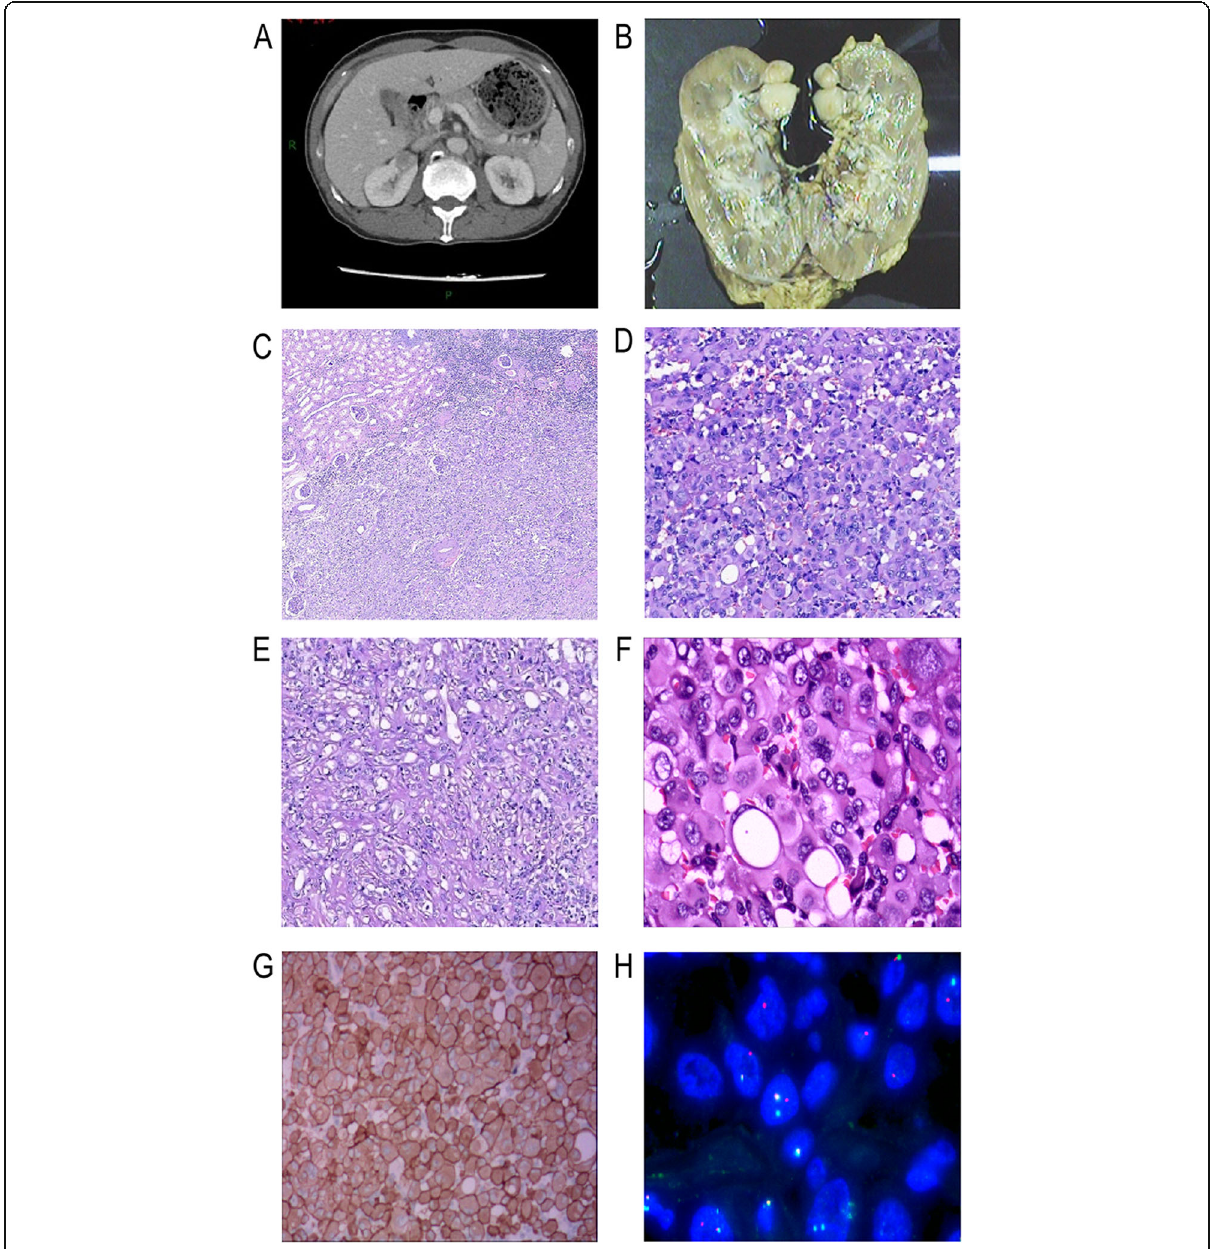
Fig. 1 a Computed tomography showed a low-density mass (19× 18 × 22 mm) in the upper pole of the right kidney; b Grossly, a unique well- circumscribed tumor of 2 cm diameter was under the renal capsule. The cut surface was faint yellow and solid; c Histologically, under the ultra low power, the tumor wasclearly demarcated from the surrounding normal renal tissue. (H&E 20×); d In the solid growth area, tumor cells were large and polygonal with abundant eosinophilic cytoplasm. Nuclei were round to oval, prominently enlarged and occasionally bizarre, with prominent nucleoli and amounts of clumped to vesicular chromatin (H&E 200×); e Histologically, in the tubular growth area, epithelial cells showed smaller in size, less cytoplasm and inconspicuous nucleoli (H&E 200×); f Under the high power, Cytoplasmic lumina and nuclear pseudoinclusions were evident. Multinucleated and rhomboid cells were focally noted and corresponded to Fuhrman grade 4 (H&E 400×); g Immunohistochemically, tumor cells showed diffuse and strong positivity for ALK (D5F3), located in the cytoplasm and cell membrane; h FISH demonstrated that 53% of the nuclei showed either isolated 3 ′ ALK signals (1R1F, 32%) or break-apart signals (1R1G1F,